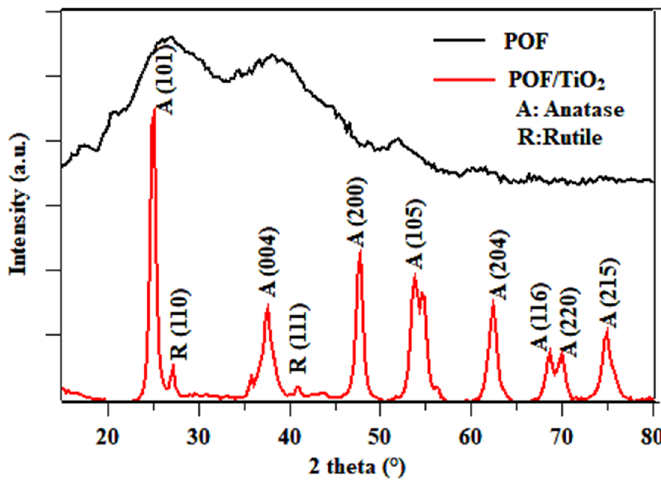
Figure 1. XRD pattern of POF and POF/TiO 2 .